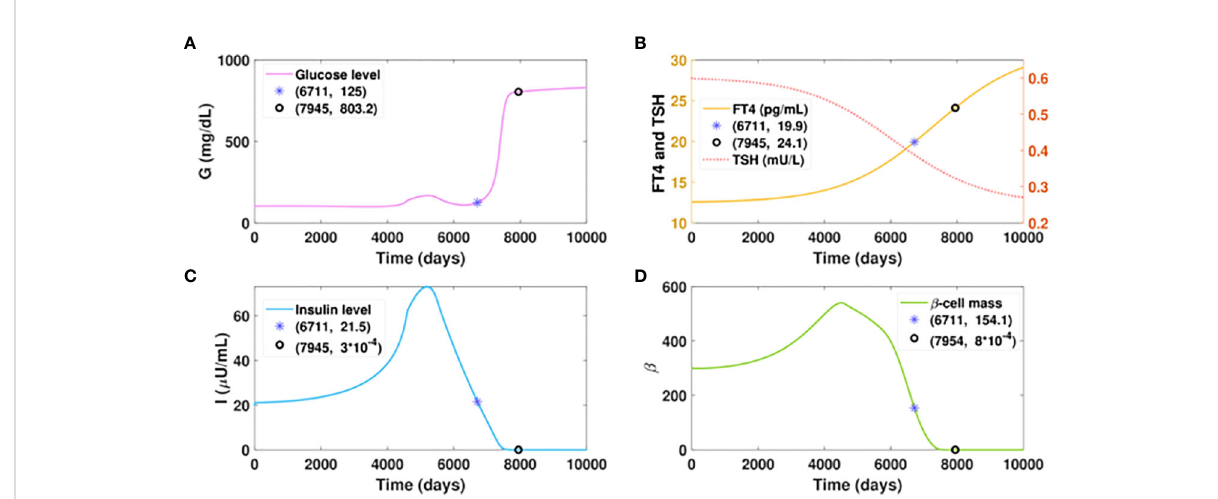
FIGURE 6 Dynamics of glucose, insulin, and functional beta-cell mass level with slowly progressing hyperthyroidism.Here a 1 ( t ) = 6 : 9 + 30 other parameter values and initial conditions remain the same as in Figure 5. (A-D) Time evolution of blood glucose concentration, plasma FT4 and TSH concentrations, insulin level, and functionalbeta-cell mass. Graph (b) shows patient B would reach the FT4 level of 20 mg/dl in approximately 18.5 years, whichis delayed 17 years than patient A. The time for him to develop diabetes would be postponed for 16.7 years, comparedwith patient A. However, patient B would step into the late stage of diabetes with an FT4 level of 24.1 pg/ml, whilepatient A just cross the threshold of diabetes with the same level of FT4.